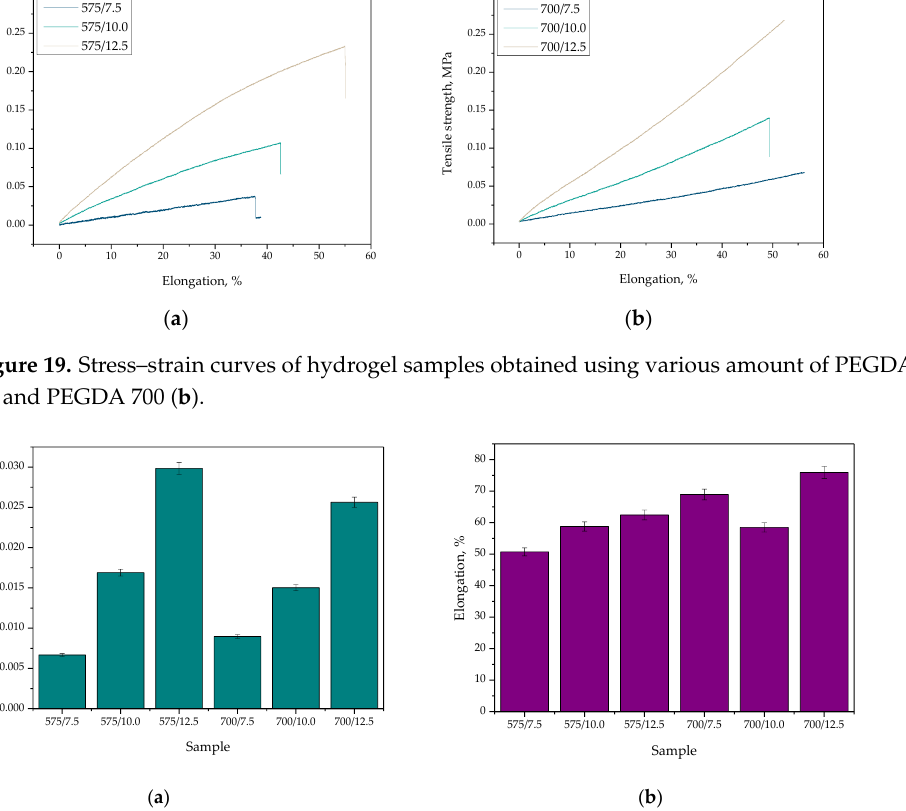
Figure 20. Mechanical characteristics of hydrogels, i.e., the tensile strength ( a ), and percentage elongation ( b ).